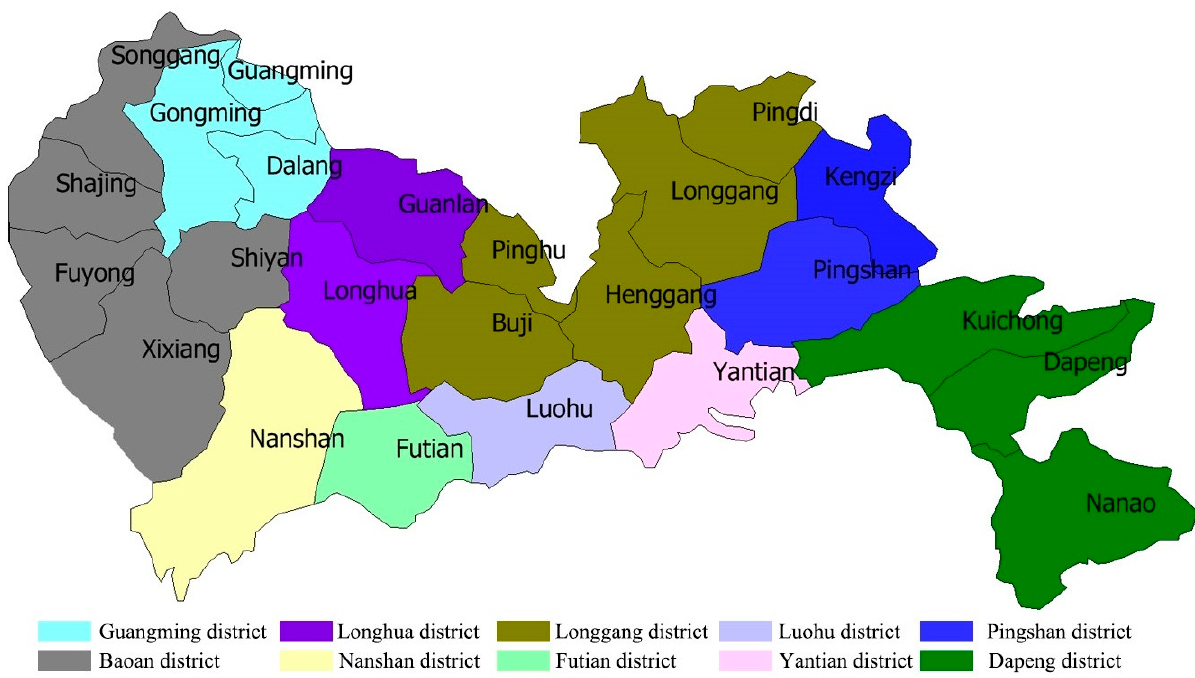
Figure 4. The administrative map of Shenzhen city.